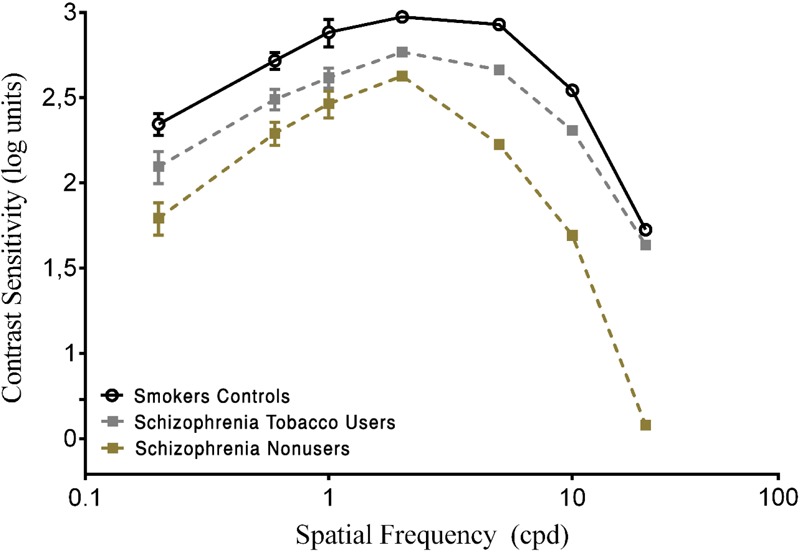
Contrast sensitivity curves as a function of spatial frequency (cpd) in the smoker control group and schizophrenia tobacco users group and schizophrenia non-users group. Each data point represents the mean sensitivity (reciprocal of contrast threshold). Error bars represent the standard deviation (SD) of the mean sensitivity. The CSF is plotted in logarithmic units.